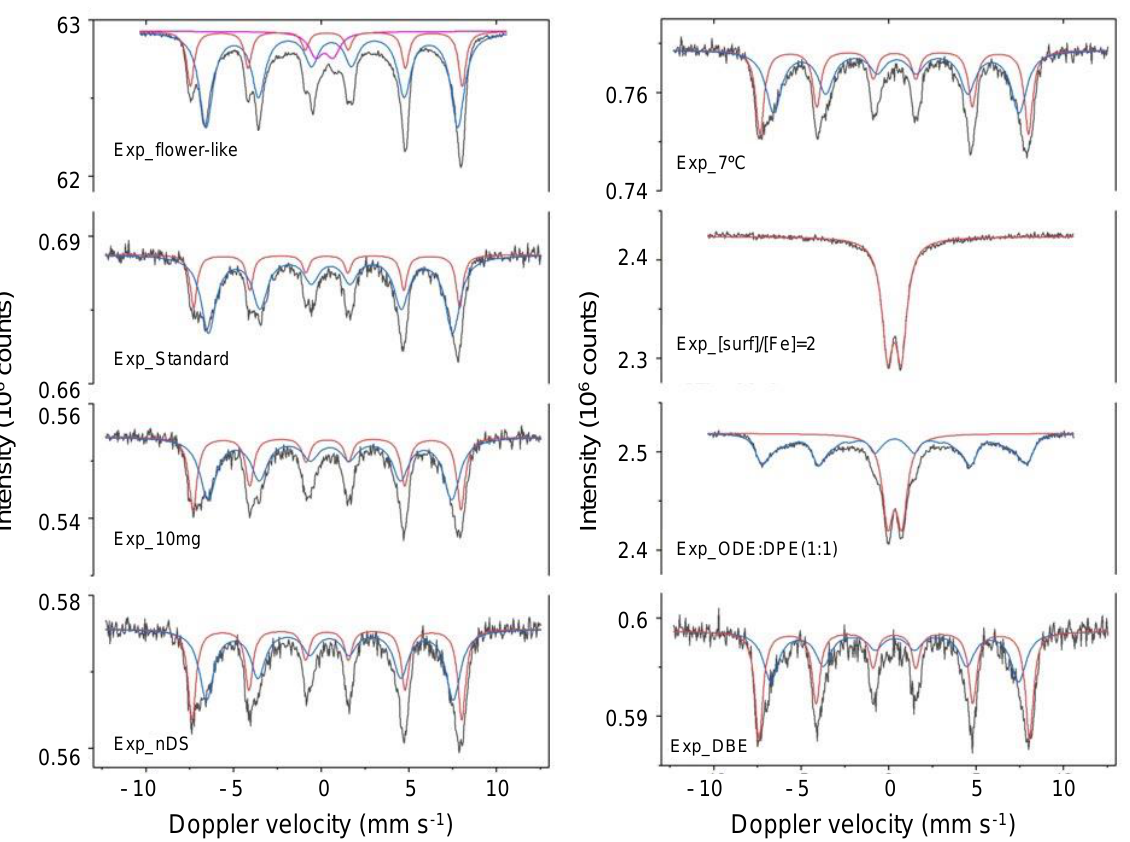
Figure 5. Mössbauer spectra of Pd/Fe-oxide NPs at 300 K. Table 4. The Mössbauer fitted parameters of Pd/Fe-oxide NPs at 300 K.